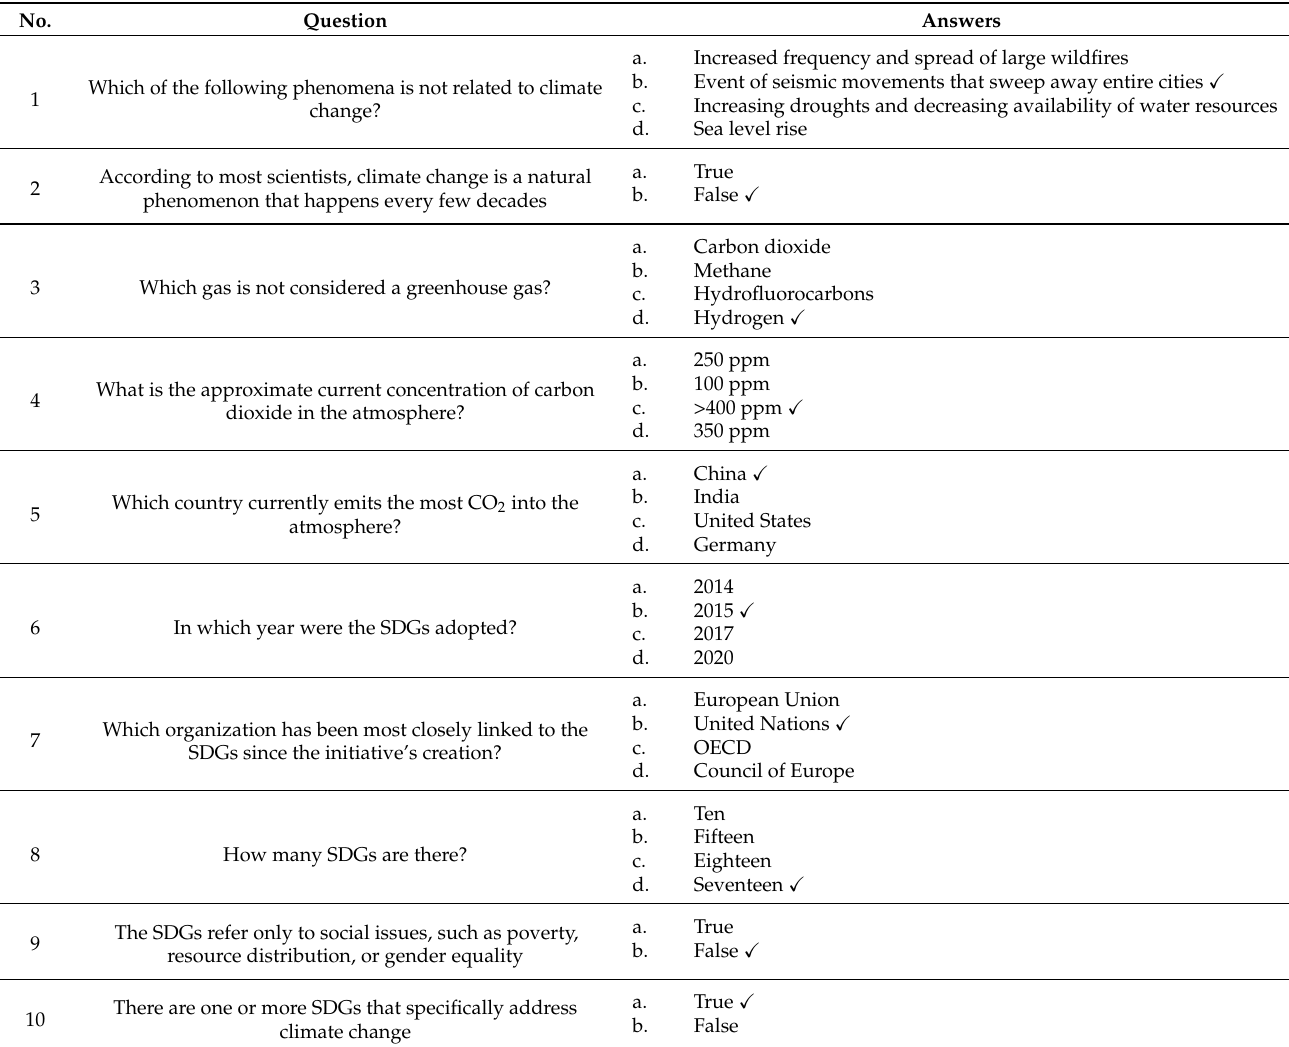
Table 4. Proposed questions for concept